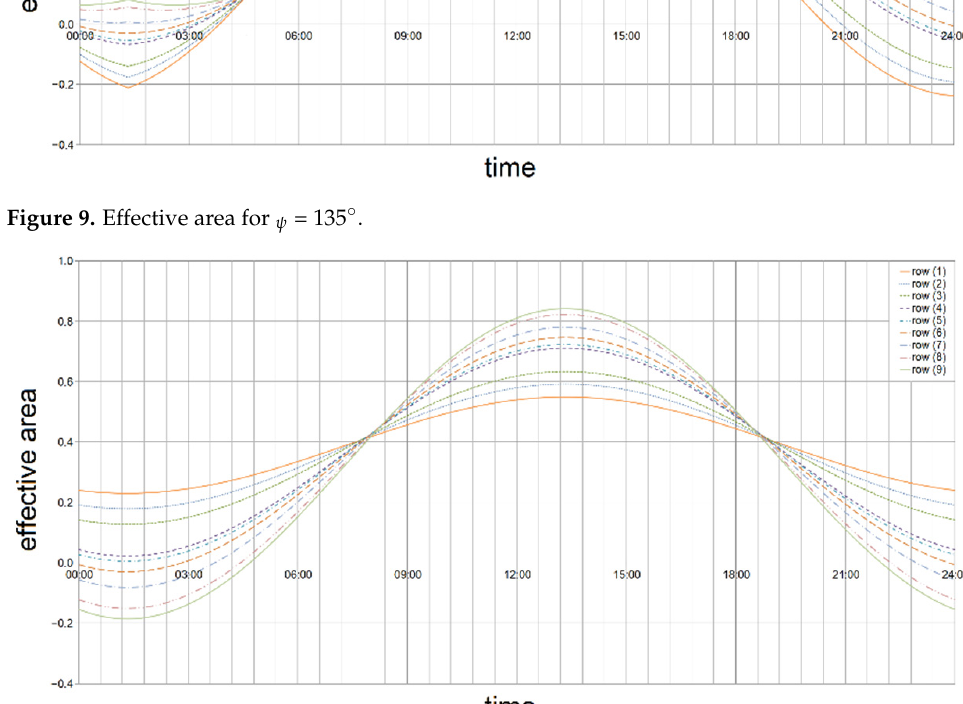
Figure 10. Effective area for ψ = 0°.